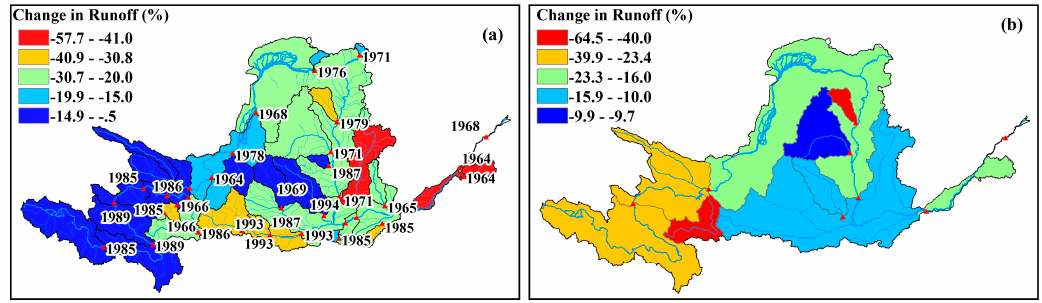
Figure 2. Change in mean annual streamflow from the benchmark (Period 1, 1960–1979) for Period 2 (1980–2000) ( a ) and Period 3 (2000–2014) ( b ). The dates shown in Figure 2a denote the times at which the change points in the streamflow series occurred.